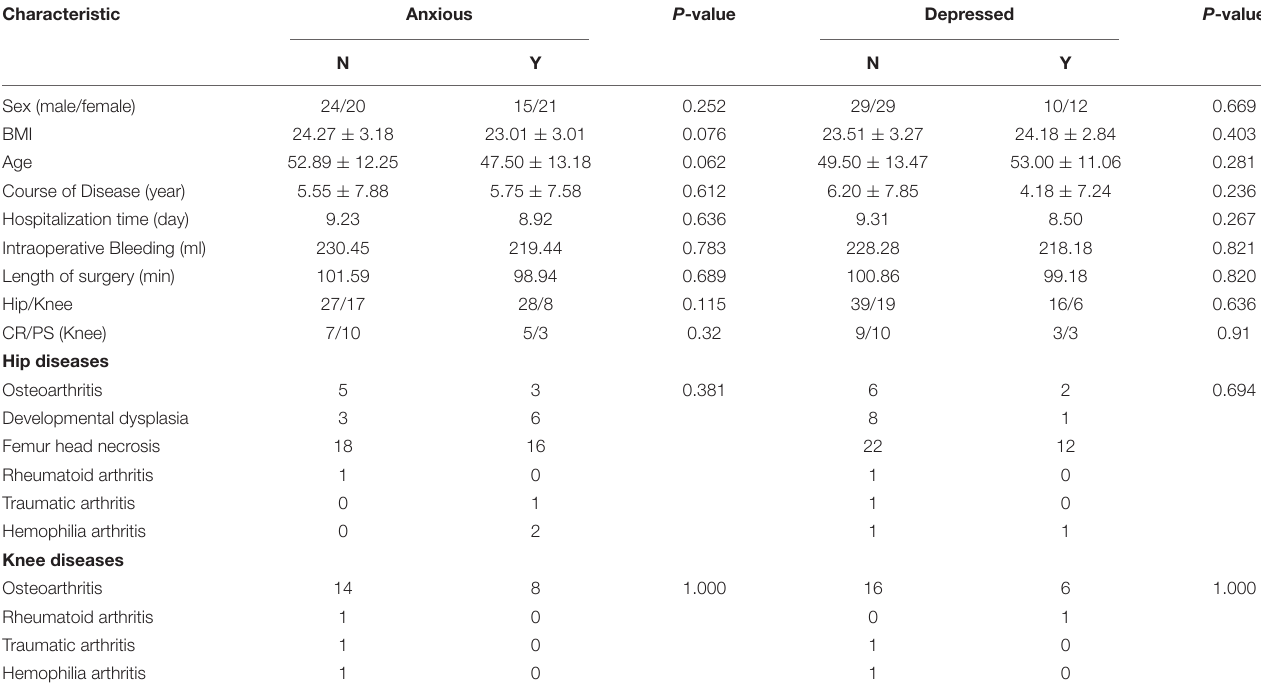
TABLE 1 | Demographic characteristics.